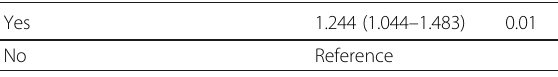
Table 4 Factors associated with consultation with a doctor among complementary and alternative